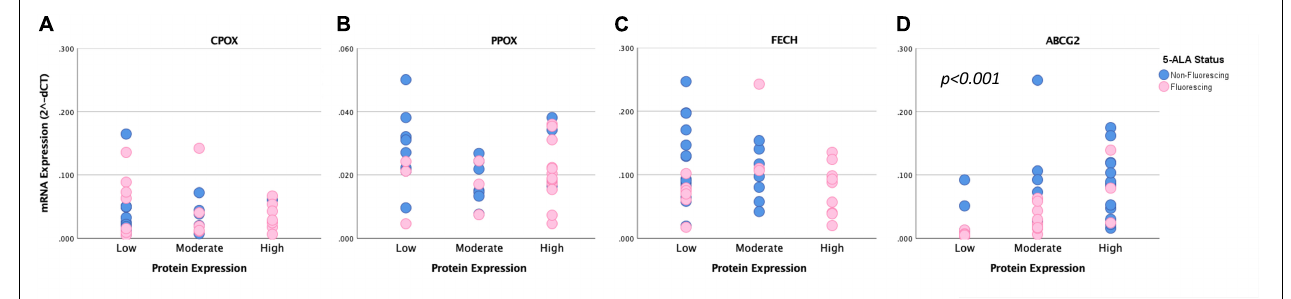
FIGURE 3 | Correlation of mRNA and protein expression of intramitochondrial heme biosynthesis factors. Scatter plot diagrams show the correlation between mRNA and protein expression levels for CPOX (A) , PPOX (B) , FECH (C) , and ABCG2 (D) . For analyses that showed a significant difference between both groups, the respective p-values are